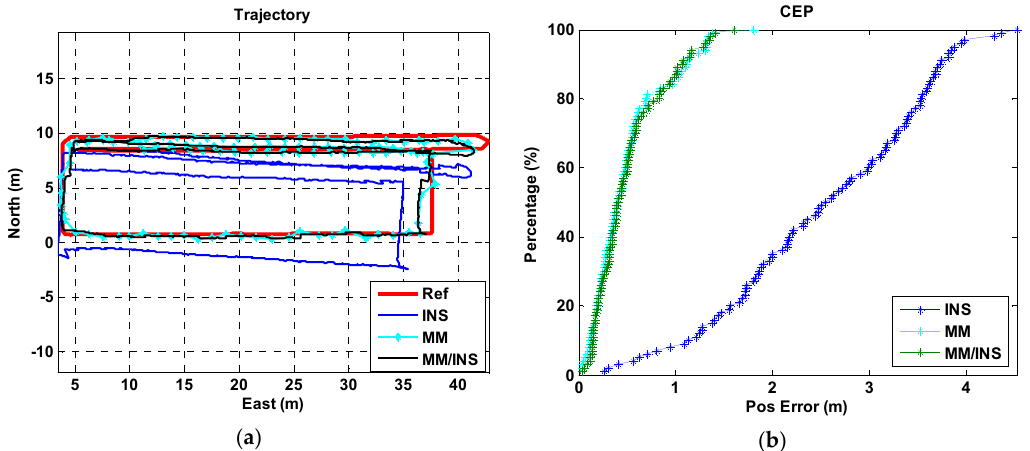
Figure 9. Navigation results of the INS, MM, and MM/INS integrated solutions in building A (Test I: Pedestrian I, Trajectory I, Google Pixel 2). ( a ) Trajectories; ( b ) cumulative error percentages.